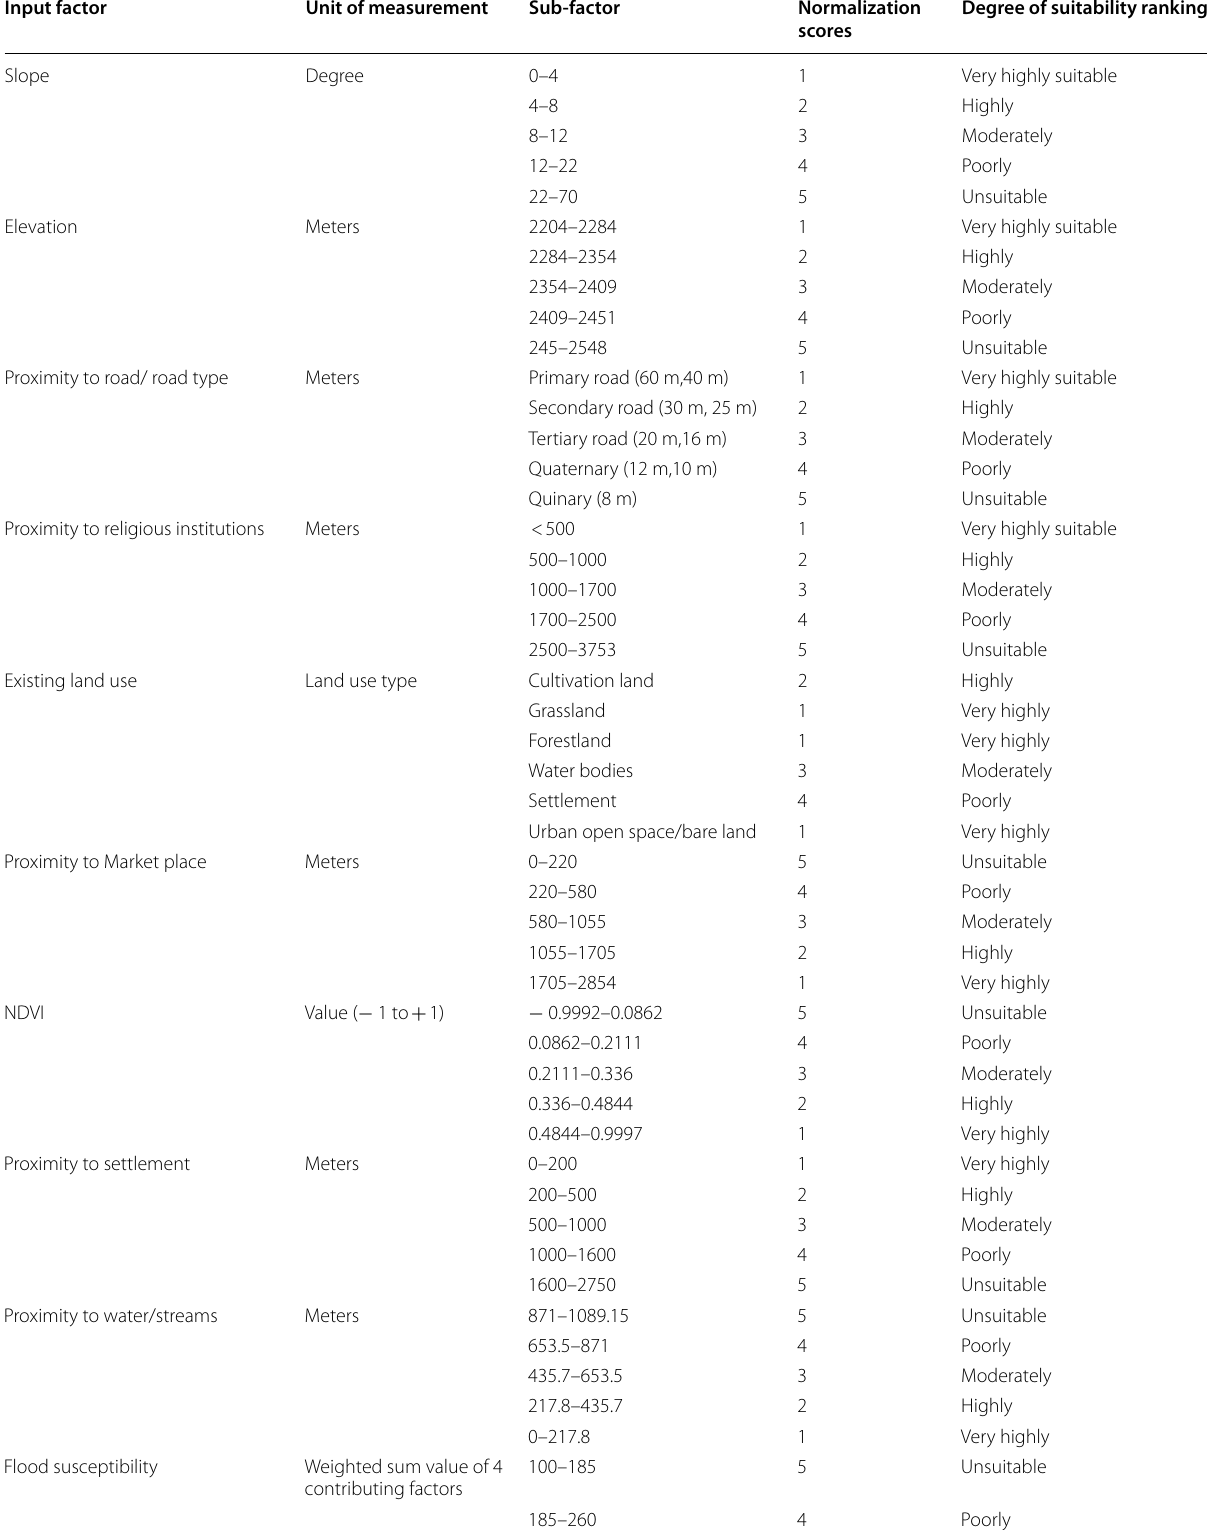
Table 4 Input factor and sub-factor with their respective normalization scores and factor degree of suitability